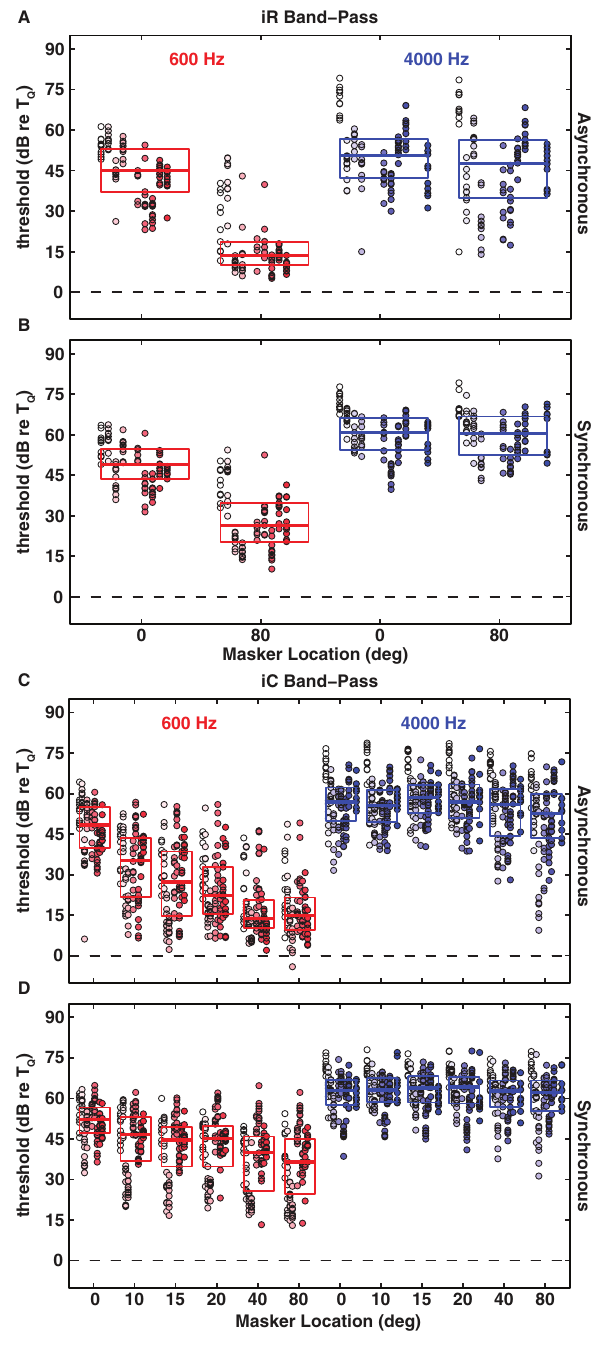
Figure 4. Signal detection thresholds re T Q in the presence of random frequency (iR: A, B) and constant frequency (iC: C, D) band-pass informational maskers as a function of masker location for the the 600-Hz (red) and the 4000-Hz (blue) signals in the asynchronous (A, C) and synchronous (B, D) timing conditions. All other conventions as in Fig. 1. Note that we tested more spatial configurations for the iC masker.